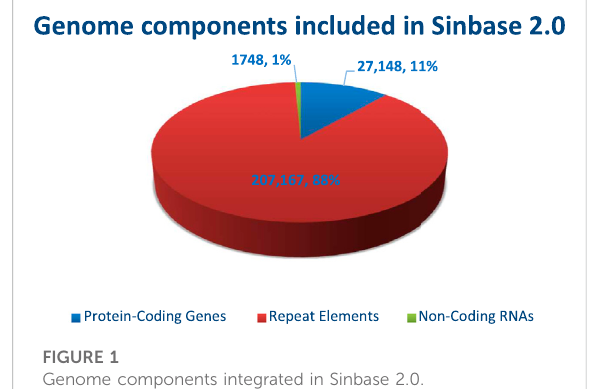
FIGURE 1 Genome components integrated in Sinbase